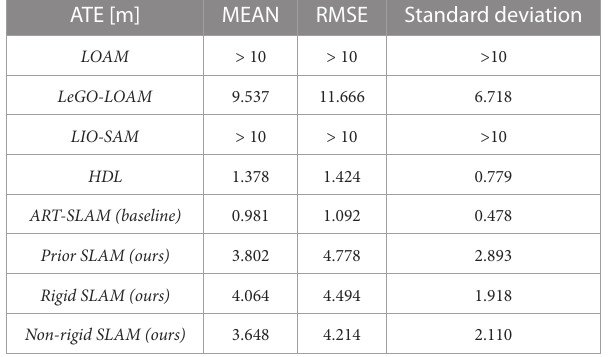
TABLE2 ATEonSequence00oftheKITTIodometrydatasetGeiger et al. (2012).